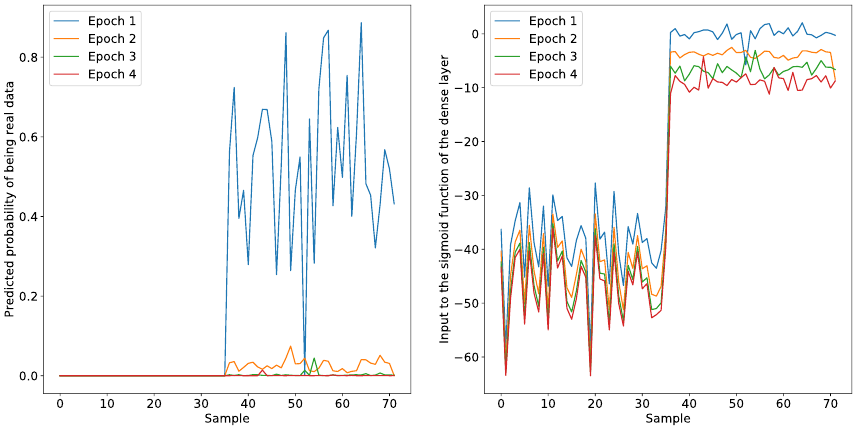
Figure 9. Predictions of the discriminator during